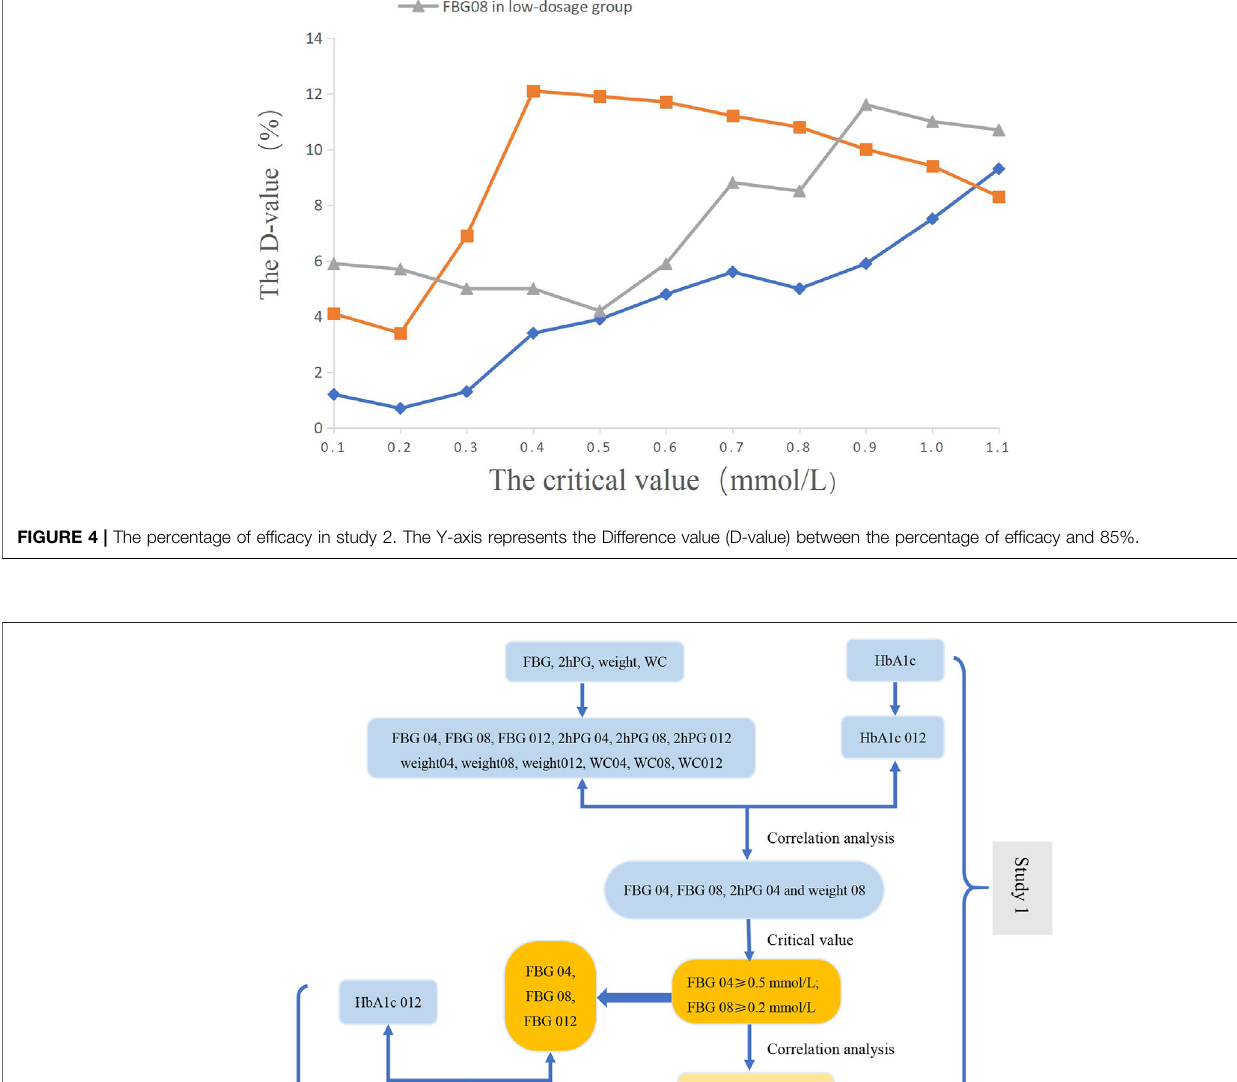
Frontiers in Pharmacology |